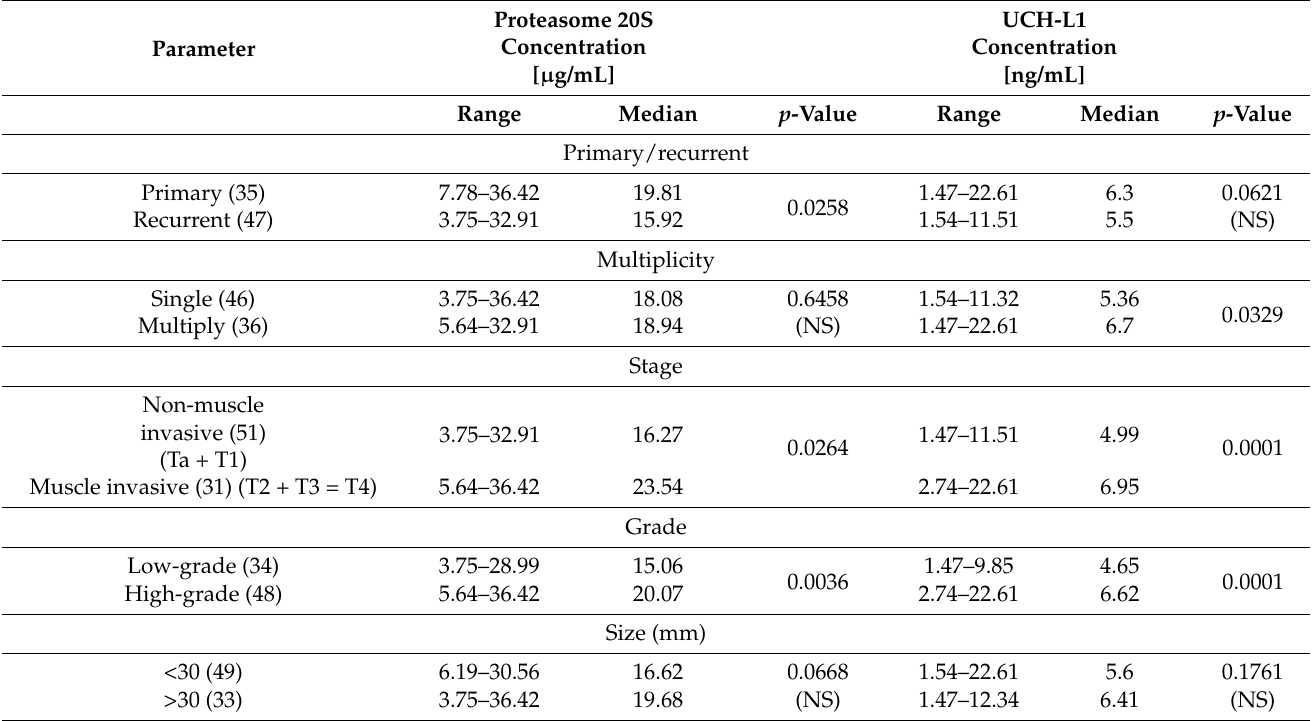
Table 3. Diagnostic characteristics of serum 20S proteasome and UCH-L1 concentration ratio compared with various clinicopathological